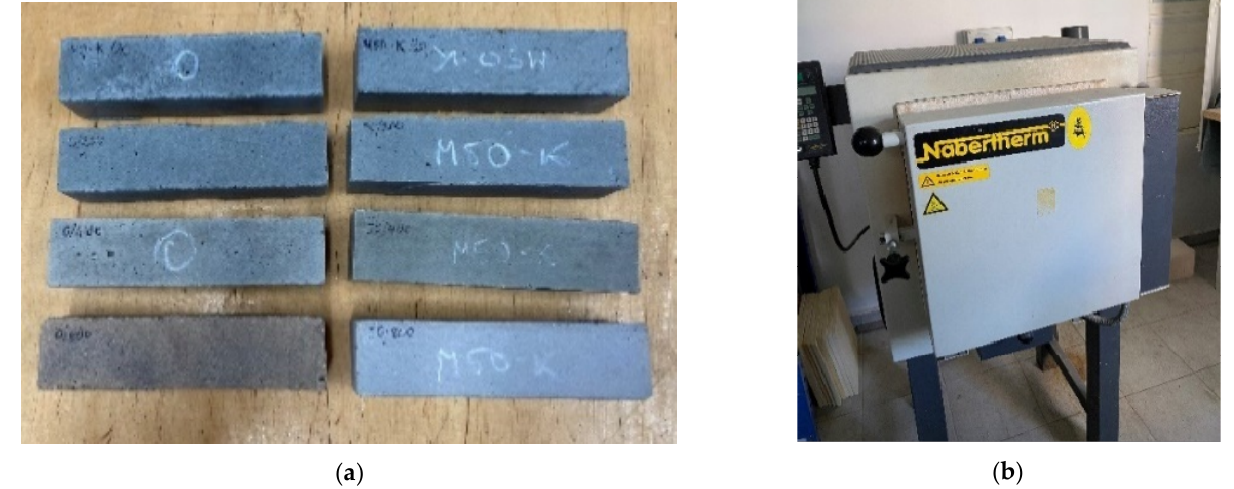
Figure 1. ( a ) Samples after being heated and cooled down, ( b ) Electric Furnace NABETHERM.